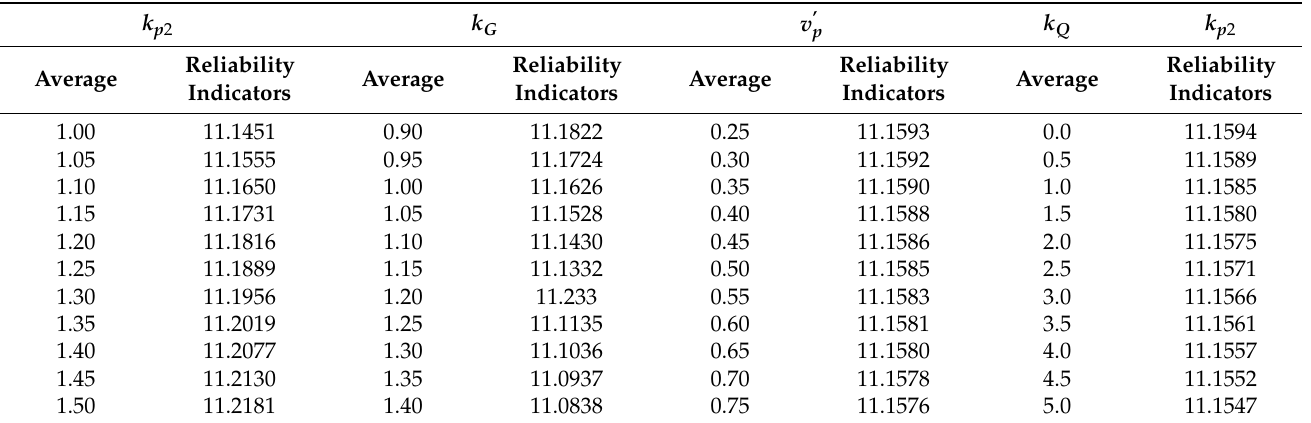
Table 4. Effect of coefficient of average value of each parameter on stability reliability index under combination